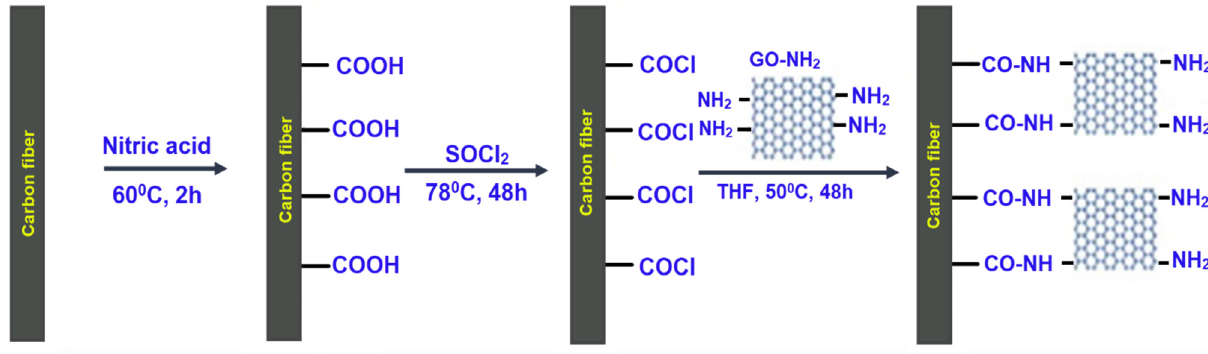
Figure 11. Schematic of grafting the functionalised graphene using SOCl 2 as the connecting agent; Reprinted with permission from [194].